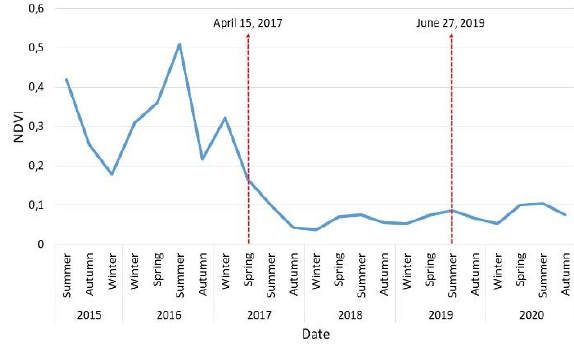
Figure 6. Sentinel-2 2015-2020 GEE seasonal average NDVI time series.